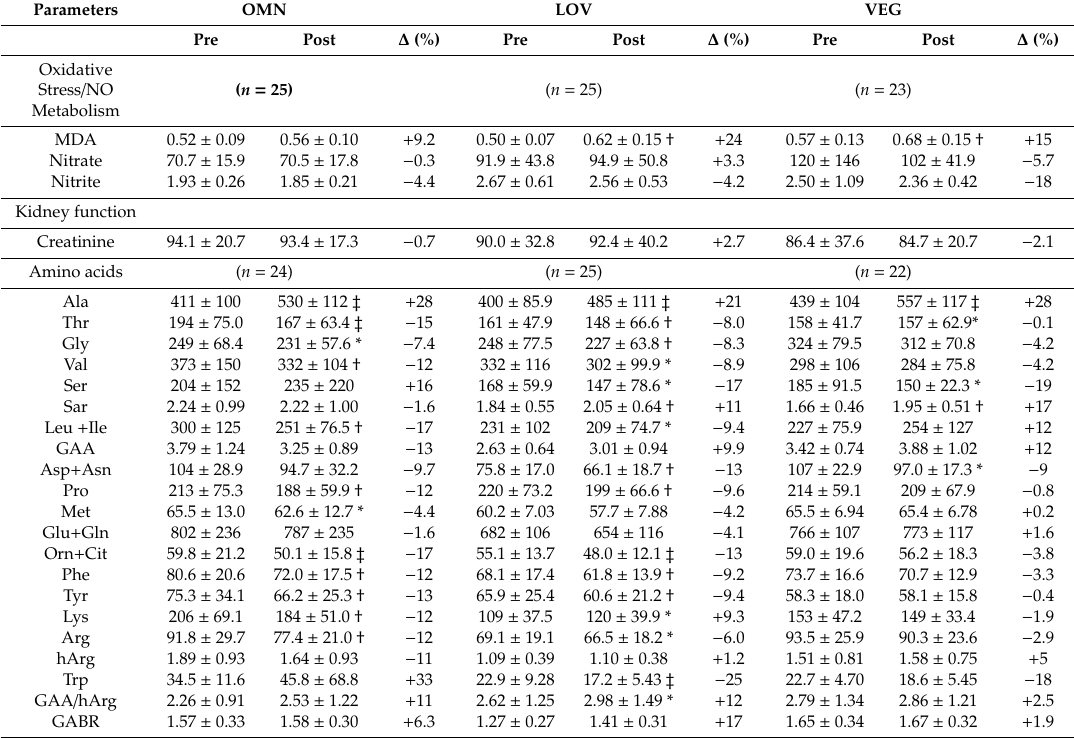
Table 3. Plasma concentrations (mean ± SD; mM for creatinine; µ M for the other analytes) and mean percentage changes ( ∆ , %) of the biochemical parameters of the three groups pre-exercise (pre) and post-exercise